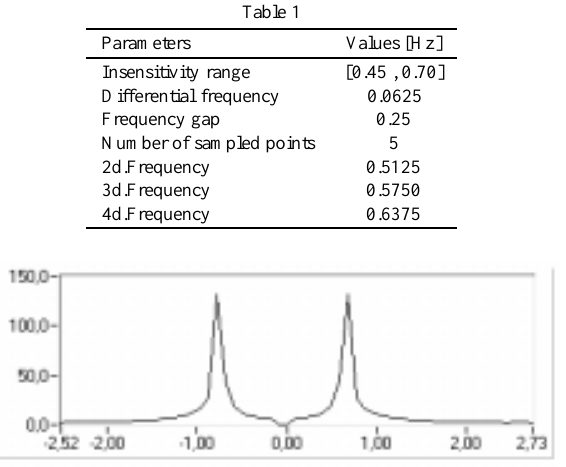
Fig. 6. FFT of the signal corresponding to the vibration of the Bob-rod physical pendulum for an intermediate bob position.